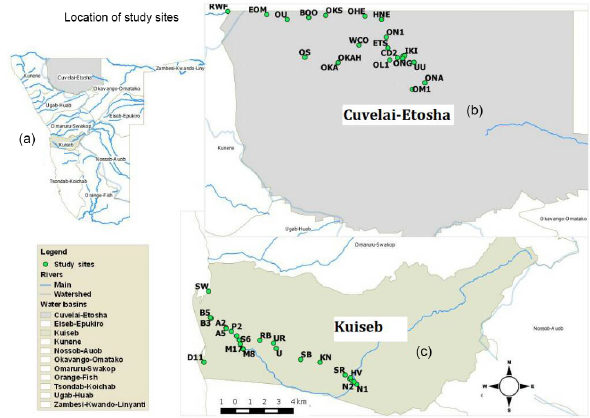
Figure 1. Map of Namibia showing the drainage basins (a) and sampling station for the Cuvelai-Etosha Basin (b) and the Kuiseb Basin (c)